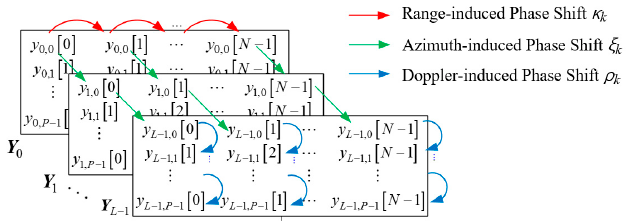
Figure 2. Illustration of the 3D phase